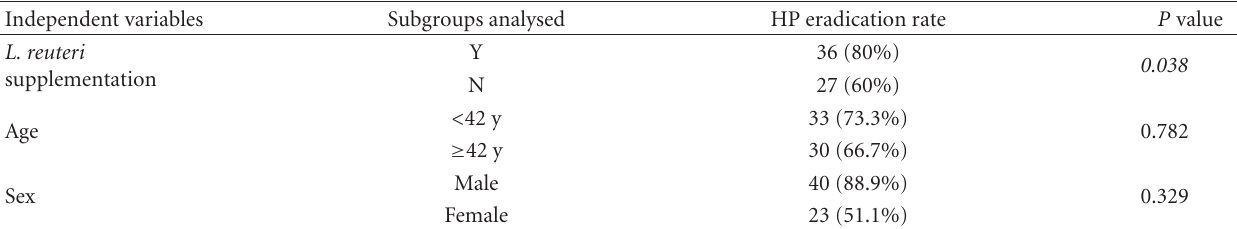
Table 1: HP-eradication: univariate analysis.